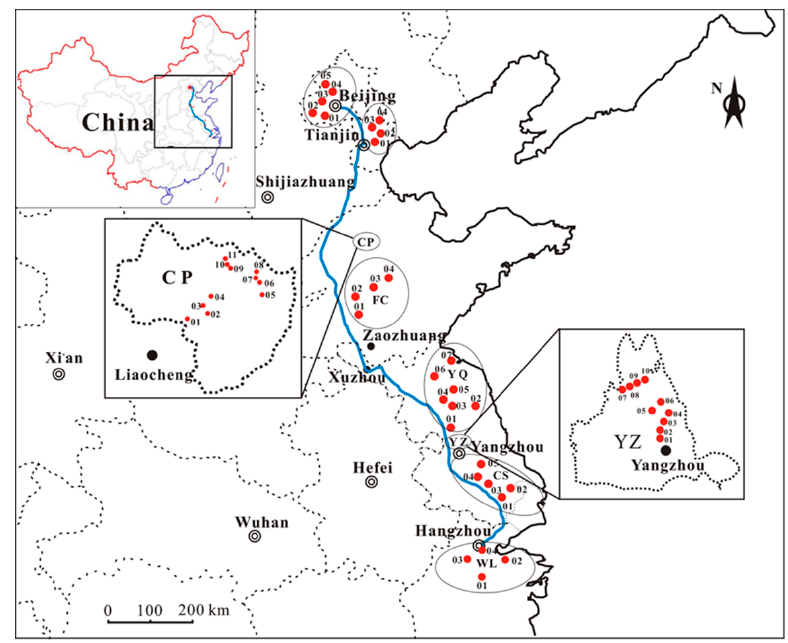
Figure 1. Sampling sites along the Grand Canal from Hangzhou to Beijing, East China.